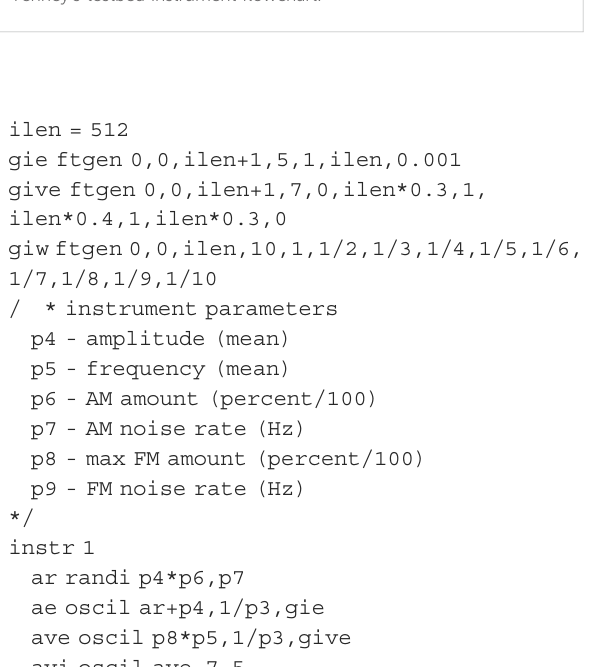
FIGURE 2 Tenney ’ s testbed instrument fl owchart.